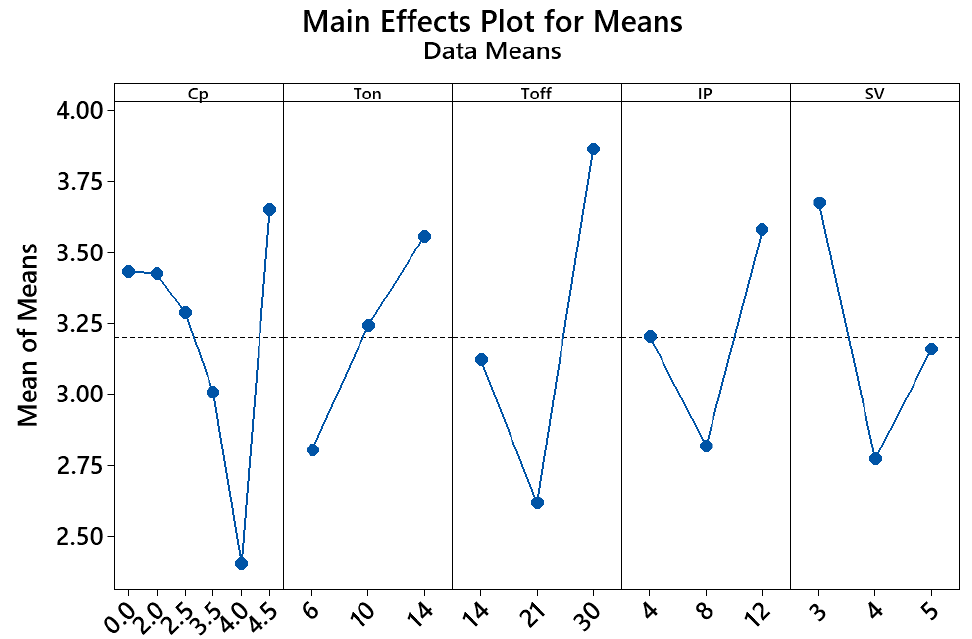
ff ects plot for roughness. Figure 6. The main effects plot for roughness. Figure 6. The main e